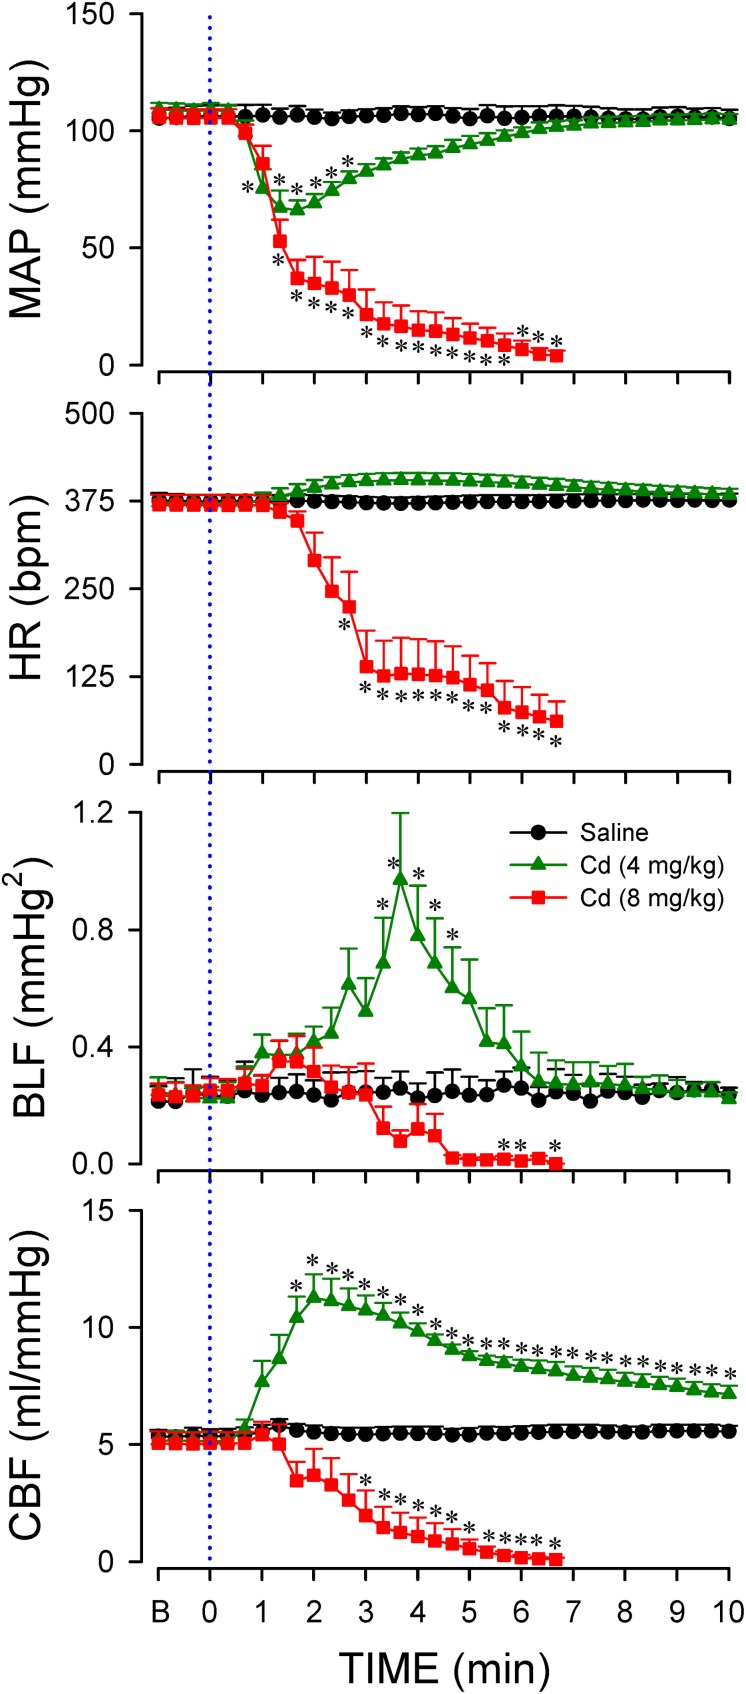
Temporal changes in mean arterial pressure (MAP), heart rate (HR), power density of the low-frequency (BLF) component of arterial pressure spectrum, or carotid blood flow (CBF) in animals that received intravenous administration of cadmium (Cd; 4 or 8 mg/kg) or saline. Values are mean ± SEM, n = 6–8 animals per experimental group. *P < 0.05 vs. saline group at corresponding time points in the post hoc Scheffé multiple-range test. Blue dotted line denotes time of cadmium injection. B denotes baseline values.